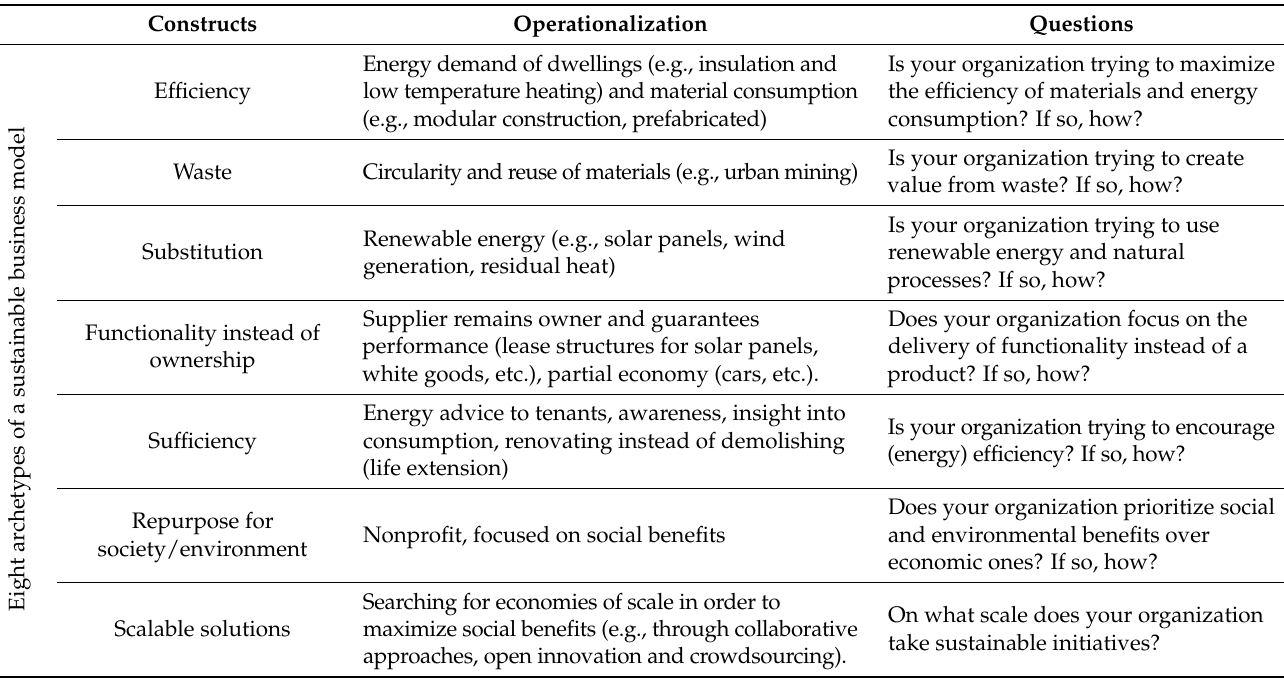
Table A2. Constructs and interview questions to assess application of sustainable business model based on [2].